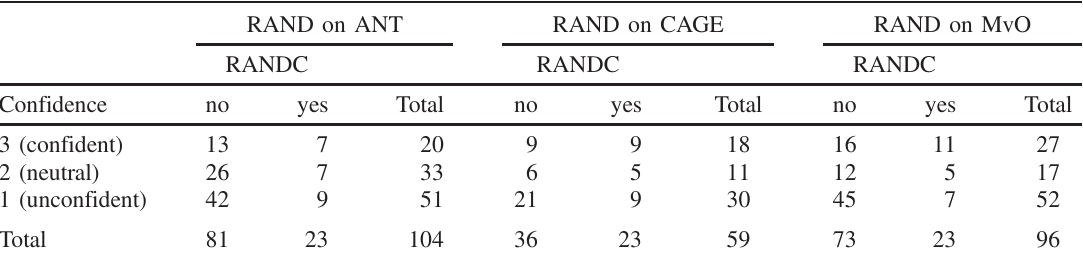
TABLE V. Confidence level of students who were assigned a RAND code on ANT (left), CAGE (middle), and/or MvO (right). Out of N ¼ 234 respondents, 23 received a RAND code on all three isomorphic prompts. These are the respondents with RANDC ∶